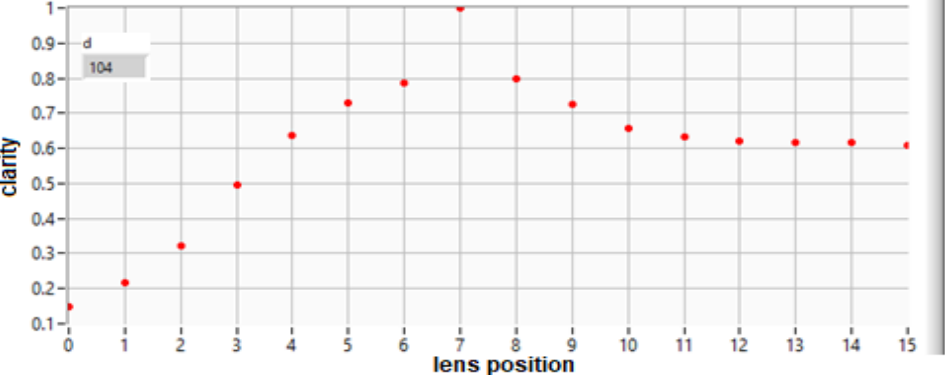
Figure 5. The clarities of a set of images (stack) for an object at 104 mm distance from the camera.